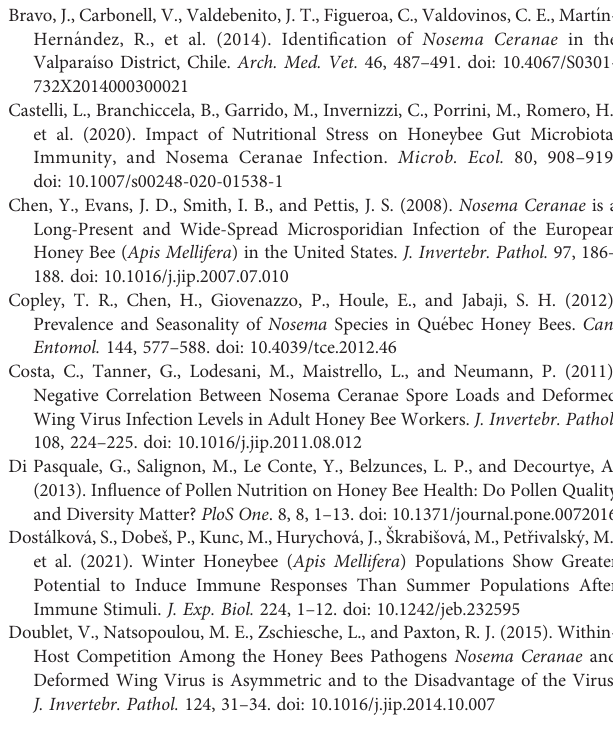
Supplementary Figure 1 | Average, maximum and minimum Temperature and relative humidity at the apiary site from May to October, 2019. Grey rectangles mark the time of spring and autumn assays. Supplementary Figure 2 | Percentage of N. ceranae infection in each colony during the spring and autumn